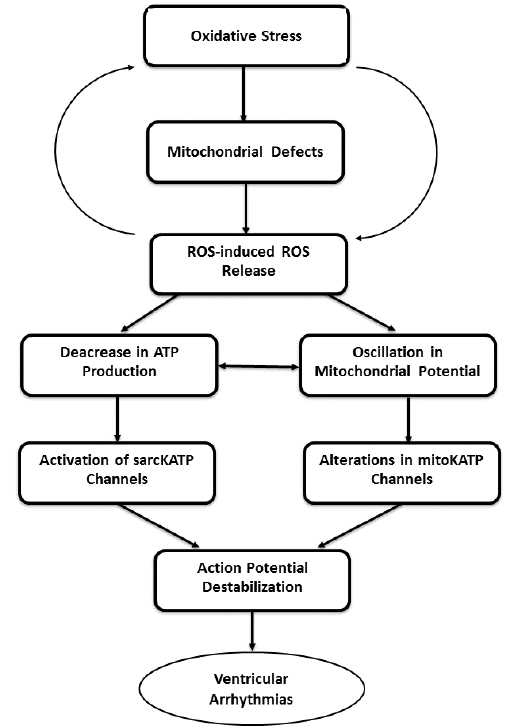
Figure 2. Events depicting the role of mitochondrial defects, reactive oxygen species (ROS)-released ROS and mitochondrial and sarcolemmal KATP channels in the generation of ventricular arrhythmias. ROS—reactive oxygen species; sarcKATP—sarcolemmal KATP channels and mitoKATP—mitochondrial KATP channels.